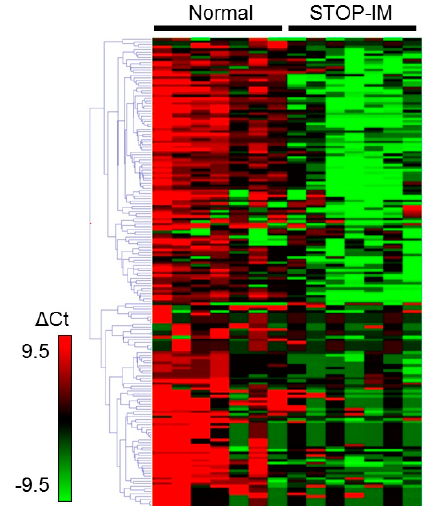
Figure 1. miRNA profiling by the TaqMan (Thermo Fischer Science, Waltham, MA, USA) miRNA array. A differential expression pattern was found between stopping imatinib (STOP-IM) patients and control subjects. Using Sequence Detection System (SDS, Version 2.4, Thermo Fisher Science, Waltham, MA, USA) and DataAssist software (Thermo Fisher Science, Waltham, MA, USA), we calculated the expression of miRNAs based on their C t value normalized by the C t value of ath-miR-159. Data were analyzed with GeneSpring software (Agilent Technologies, Santa Clara, CA, USA).